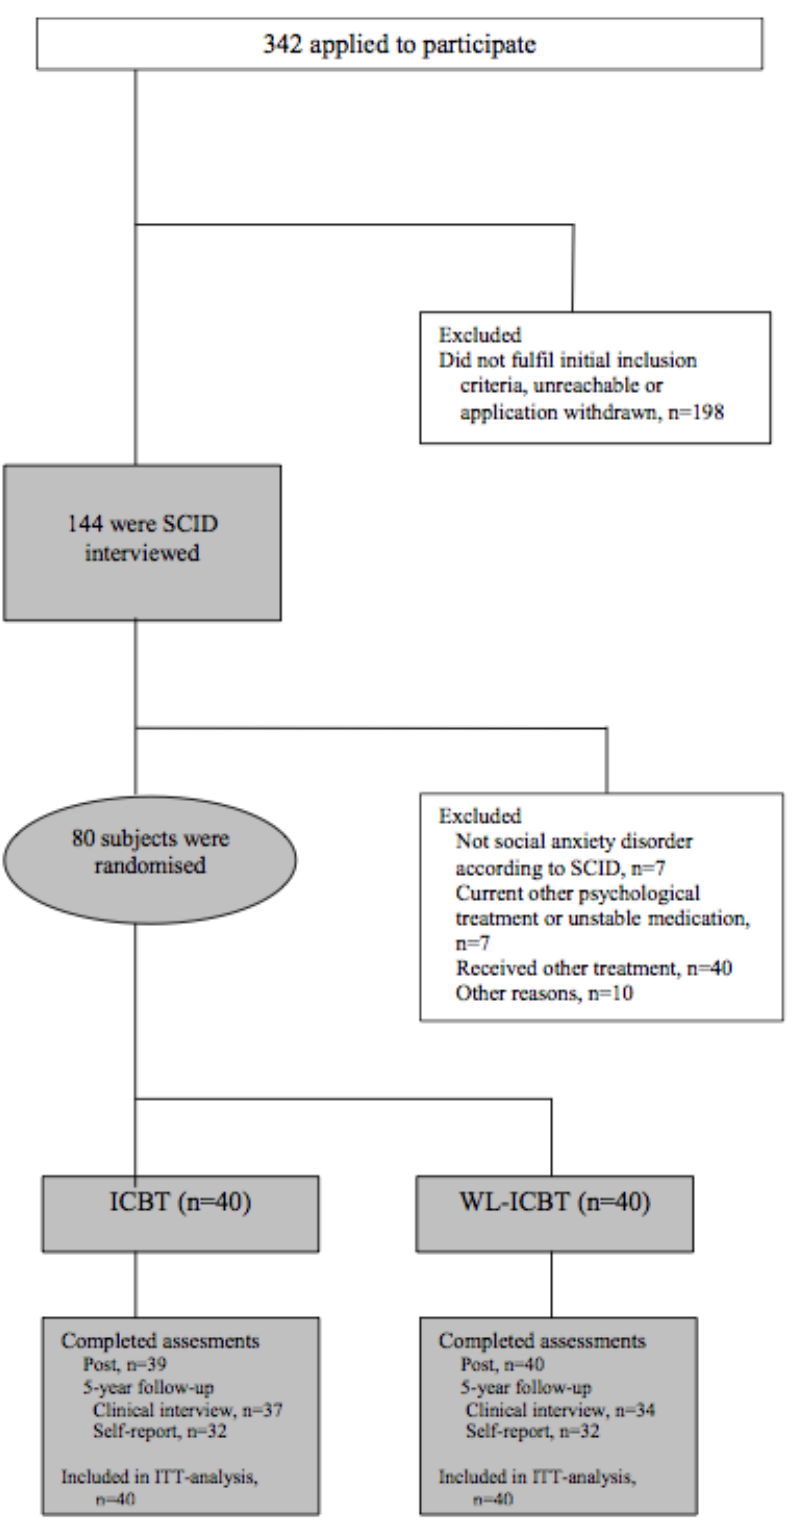
Figure 1. Participant